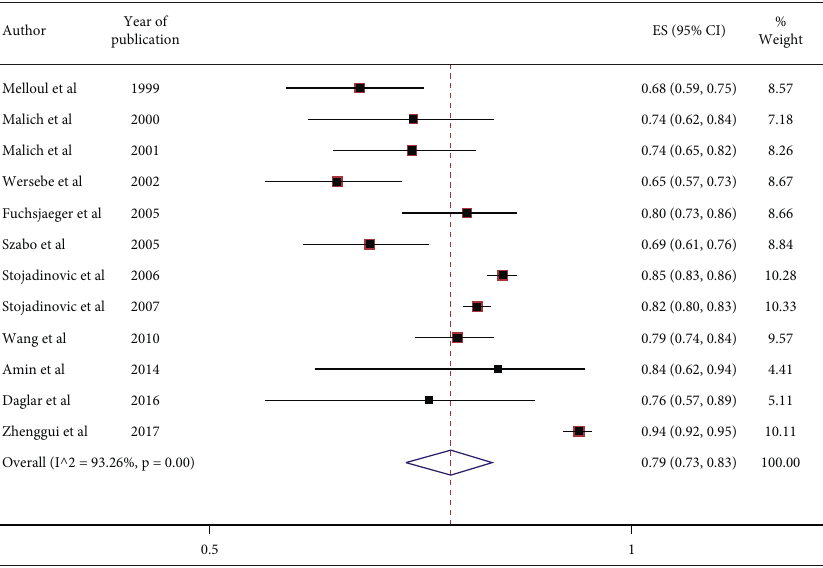
Figure 4: Forest plot of accuracy.